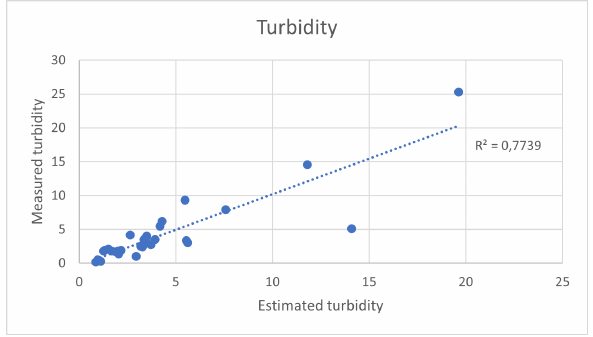
Figure 8. Correlation between the measured turbidity and the estimated turbidity.